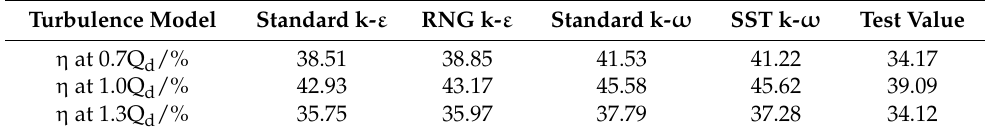
Table 2. Results from the numerical calculation and experiment with different turbulent models. Turbulence Model